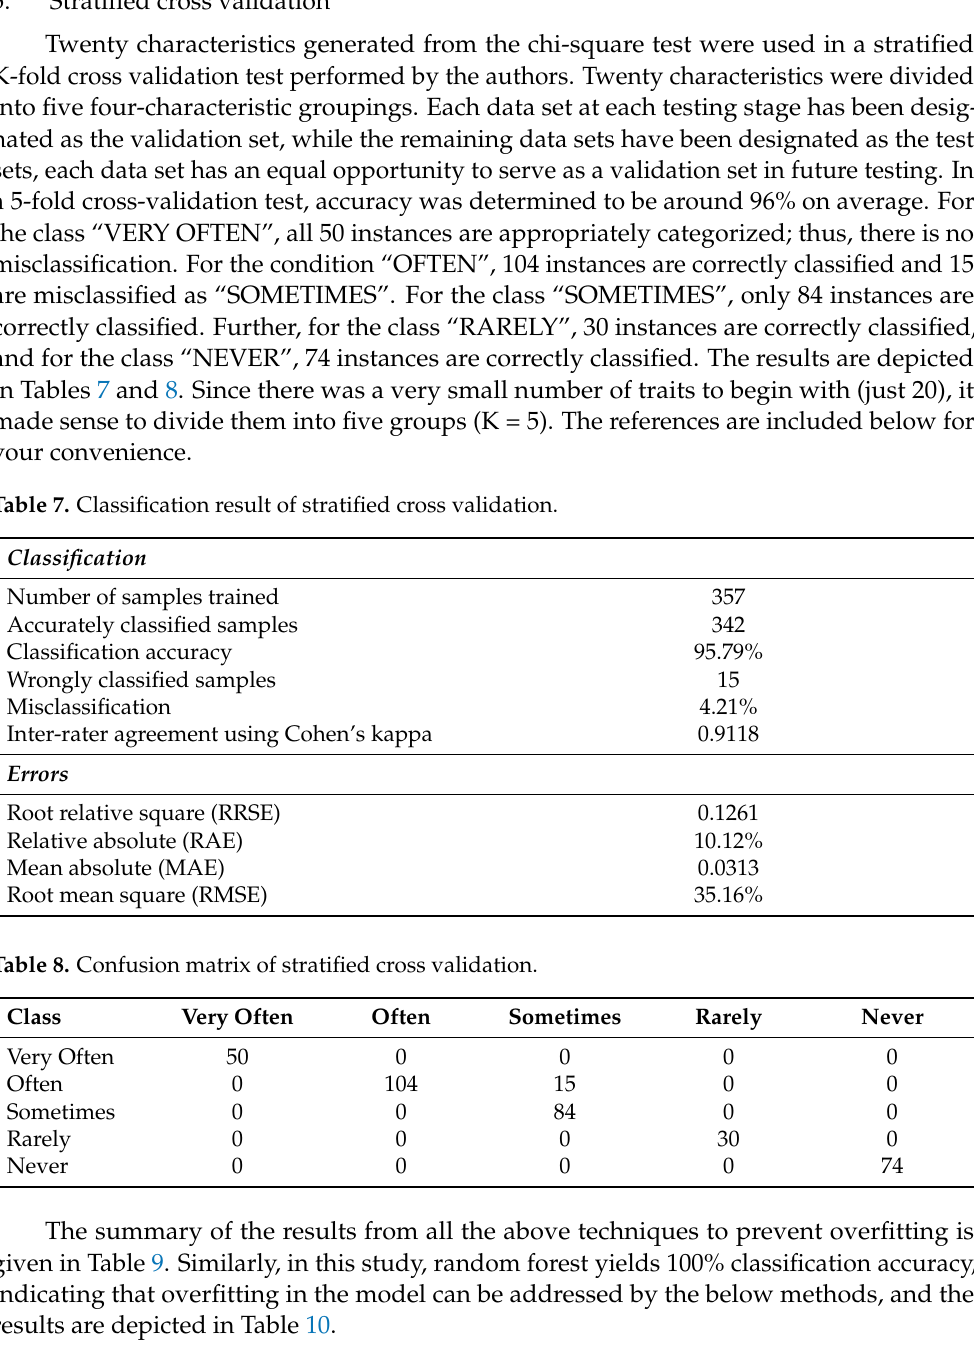
Table 9. Results of preventive techniques (decision